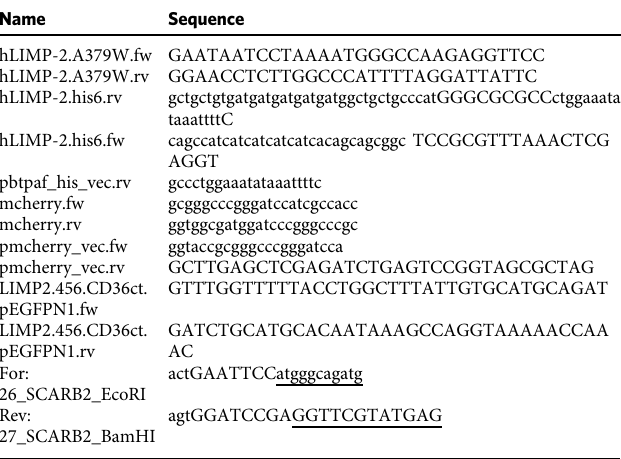
Fig. 3 LIMP-2-WT but not LIMP-2-G379W/V415W overexpression rescues cholesterol ef fl ux from LEs in LIMP-2 de fi cient cells. a Principle of late endosomal BODIPY-cholesterol (BC) ef fl ux assay in A431 cells. Cells are loaded for 24 h with oleic acid-conjugated BSA to generate lipid droplets (LD). In parallel, cells are labeled with dextran to visualize late endosomal organelles (LE). Cells are then labeled for 2 h with BODIPY cholesteryl linoleate-labeled LDL (BC LN-LDL) that enters LE, and chased in serum-free medium to monitor the transfer of BC from LE to LD (labeled with LipidTox during the last 30 min of BC-LN-LDL labeling). b Overlaid confocal images of BC (green), dextran/LIMP-2 (blue), and LipidTox (red) in live A431 cells transfected with the indicated siRNAs and/or cDNA constructs (LIMP-2-WT or LIMP-2-G379W/V415W overexpressing cells are outlined) at 0 h and 4 h of chase. Scale